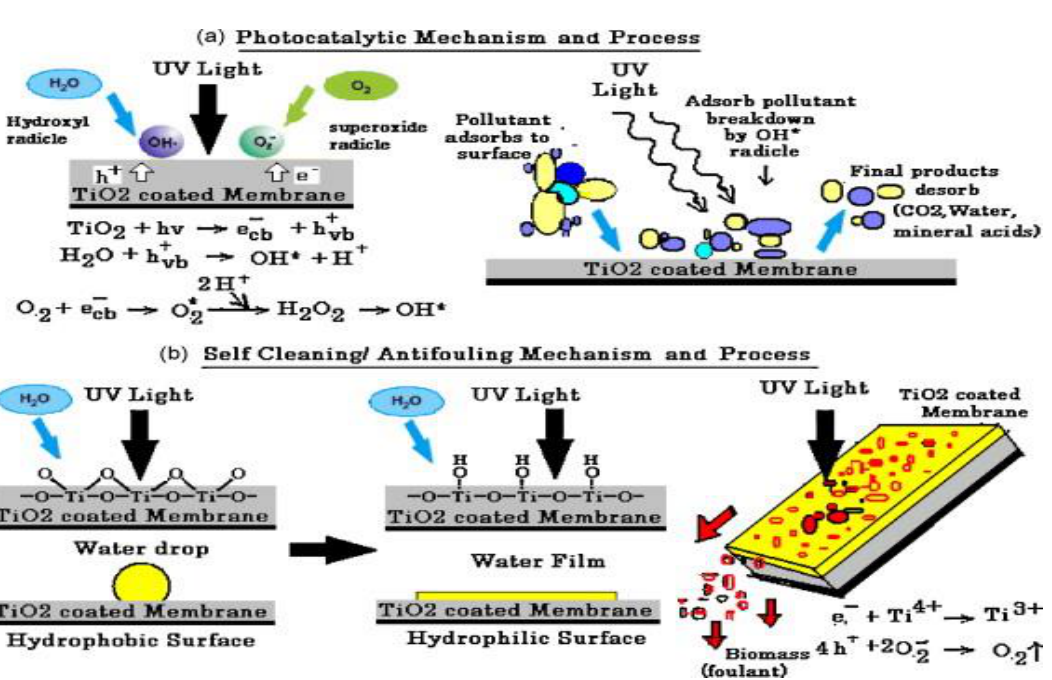
Figure 10. Degradation mechanism of new fuchsin via ( a ) photocatalytic and ( b ) photosensitization pathways using GQDs under visible light irradiation. Reproduced form [192].